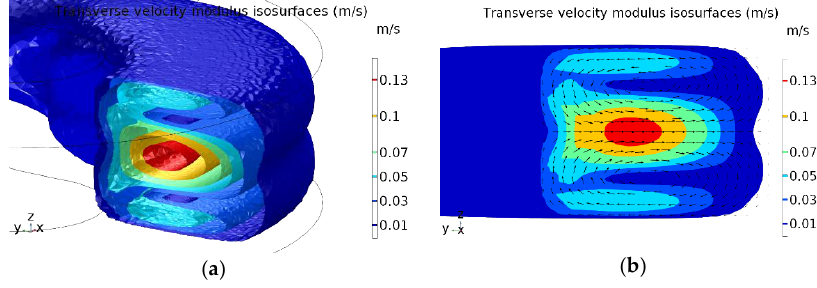
Figure 8. ( a ) Isosurfaces of the transverse velocity flow modulus cut through y - z plane; ( b ) Plane view of the cut section. The null transverse velocity paths are visible at the center of the Dean vortices.